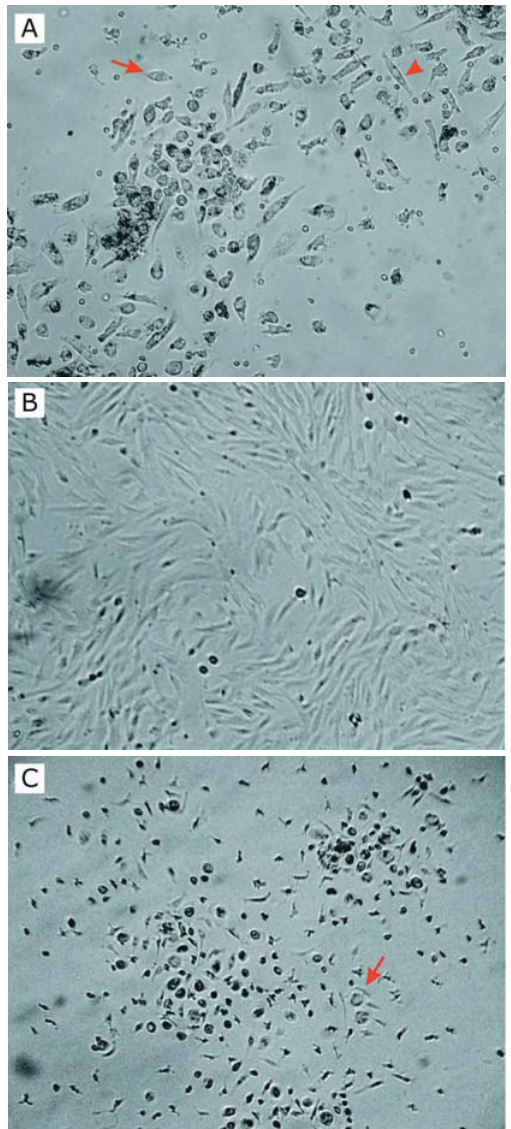
Fig. 1 - Fotomicrografia mostrando células aderentes provenientes do sangue de cordão umbilical. A. Células fibroblastóides (seta) e epitelióides (ponta de seta) observadas no início de cultivo. B. Células fibroblastóides confluentes. C. Células arredondadas (seta). Aumento 200x